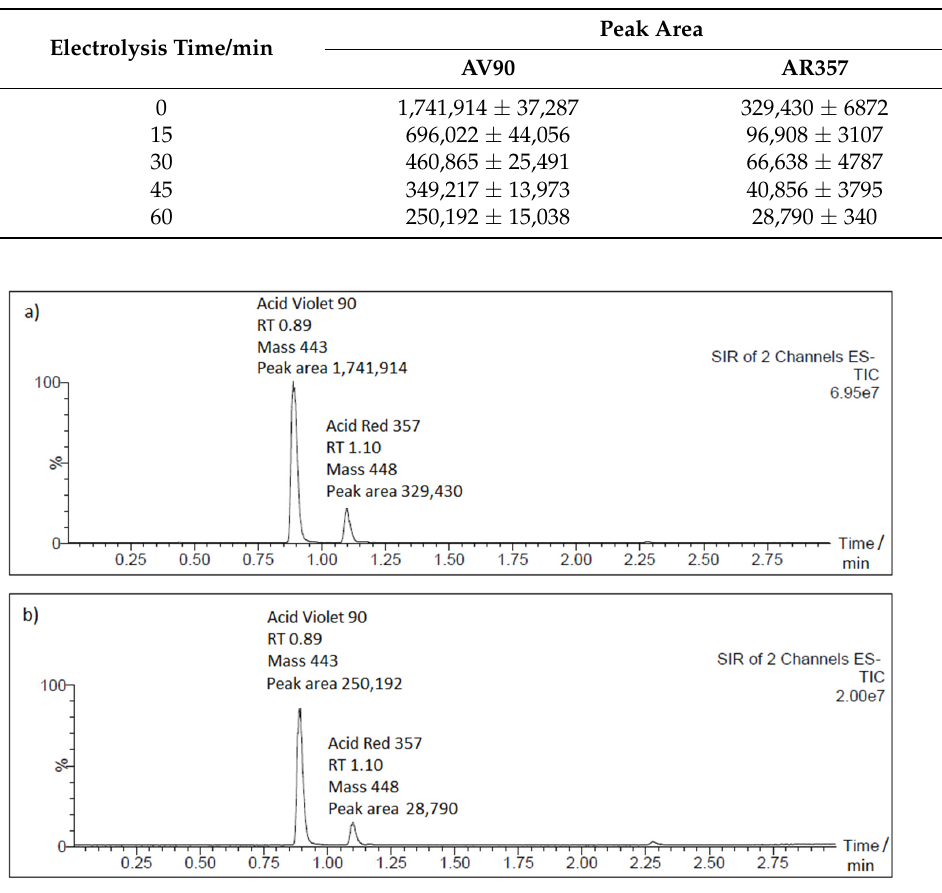
Figure 7. Representative UPLC-MS/MS chromatograms for AM: ( a ) before; ( b ) after 60 min of continuous electrolysis.